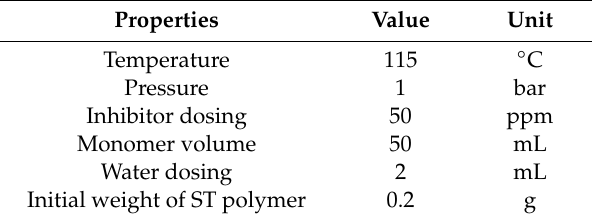
Figure 6. The schematic diagram of experimental setup. Table 1. Experimental conditions.